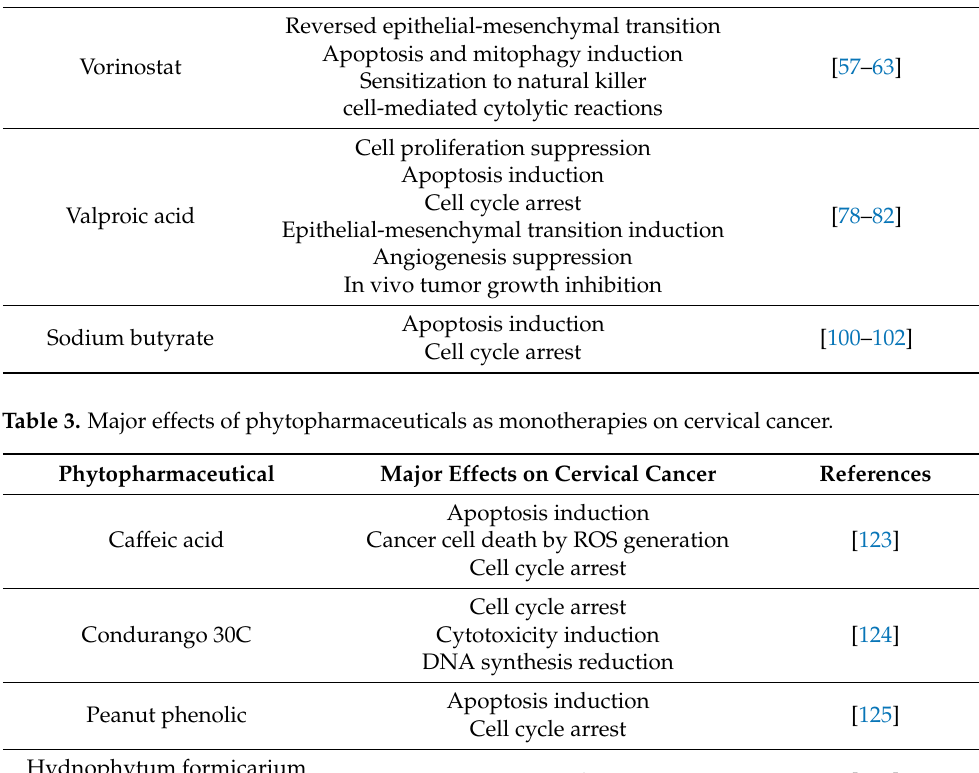
Table 2. Major effects of the most studied HDACIs as monotherapies on cervical cancer. HDACI